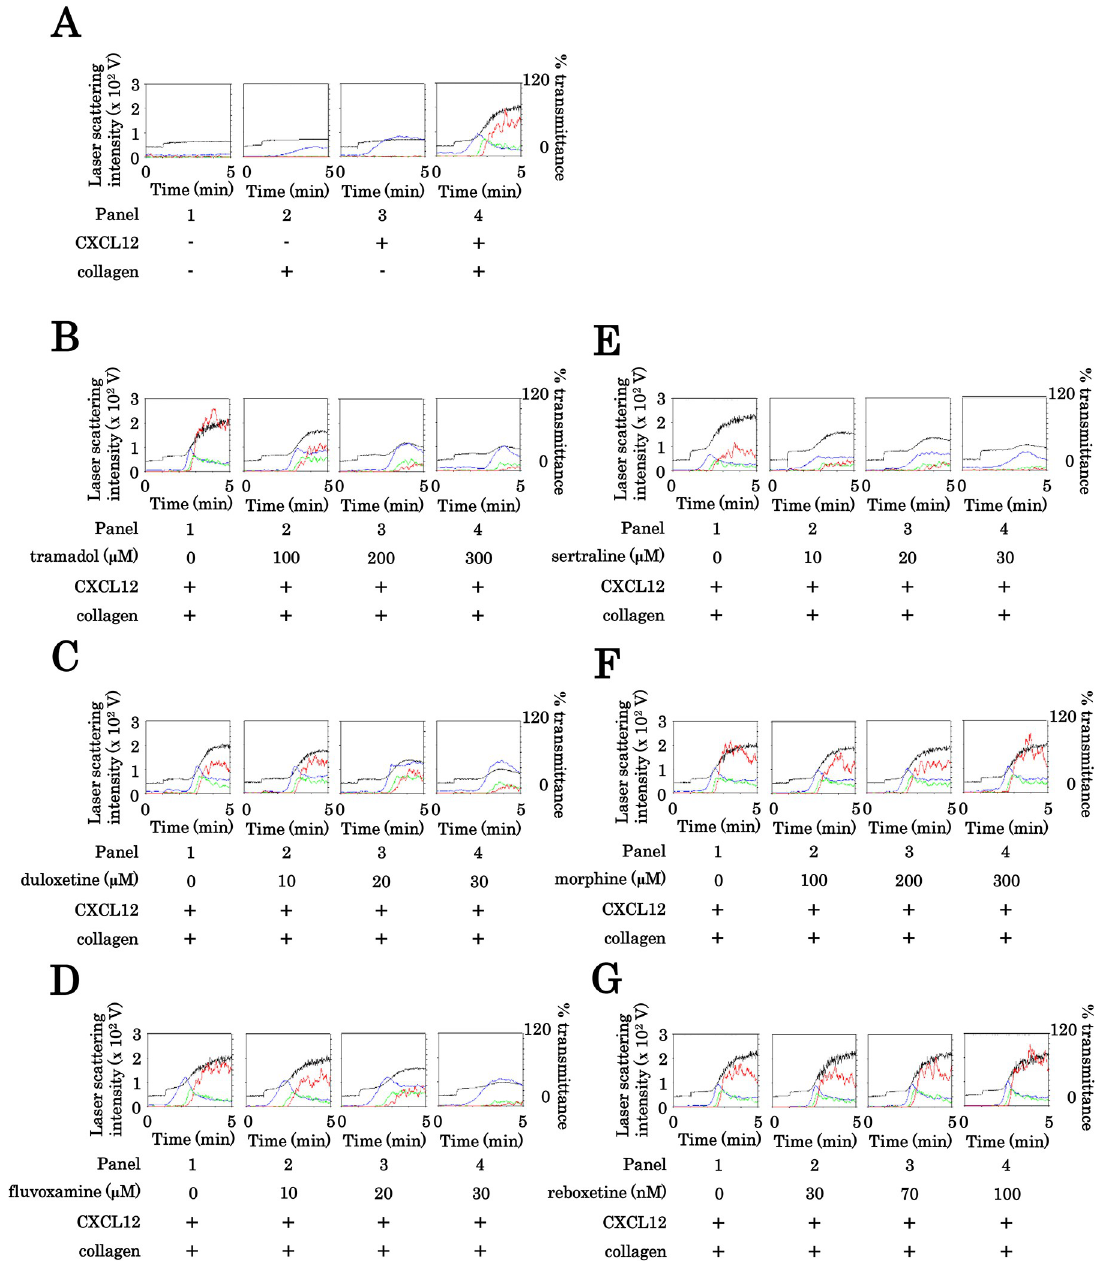
Fig 1. Effects of tramadol, duloxetine, fluvoxamine, sertraline, morphine or reboxetine on the platelet aggregation induced by the simultaneous stimulation with subthreshold collagen and CXCL12. (A) PRP was stimulated simultaneously by the combination of 0.2 μ g/ml of collagen or vehicle and 10 ng/ml of CXCL12 or vehicle for 5 min. (B, C, D, E, F, G) PRP was pretreated with 0 μ M, 100 μ M, 200 μ M or 300 μ M of tramadol (B), 0 μ M, 10 μ M, 20 μ M or 30 μ M of duloxetine (C), 0 μ M, 10 μ M, 20 μ M or 30 μ M of fluvoxamine (D), 0 μ M, 10 μ M, 20 μ M or 30 μ M of sertraline (E), 0 μ M, 100 μ M, 200 μ M or 300 μ M of morphine (F), 0 nM, 30 nM, 70 nM or 100 nM of reboxetine (G) for 3 min, and then stimulated simultaneously by the combination of 0.075–0.45 μ g/ml of collagen and 10 ng/ml of CXCL12 for 5 min. The representative results from 3 independent individuals are shown. The black line indicates the percentage of transmittance of each sample (isolated platelets recorded as 0%, and platelet-poor plasma recorded as 100%). The blue line indicates small aggregates (9–25 μ m); green line, medium aggregates (25–50 μ m); red line, large aggregates (50–70 μ m).